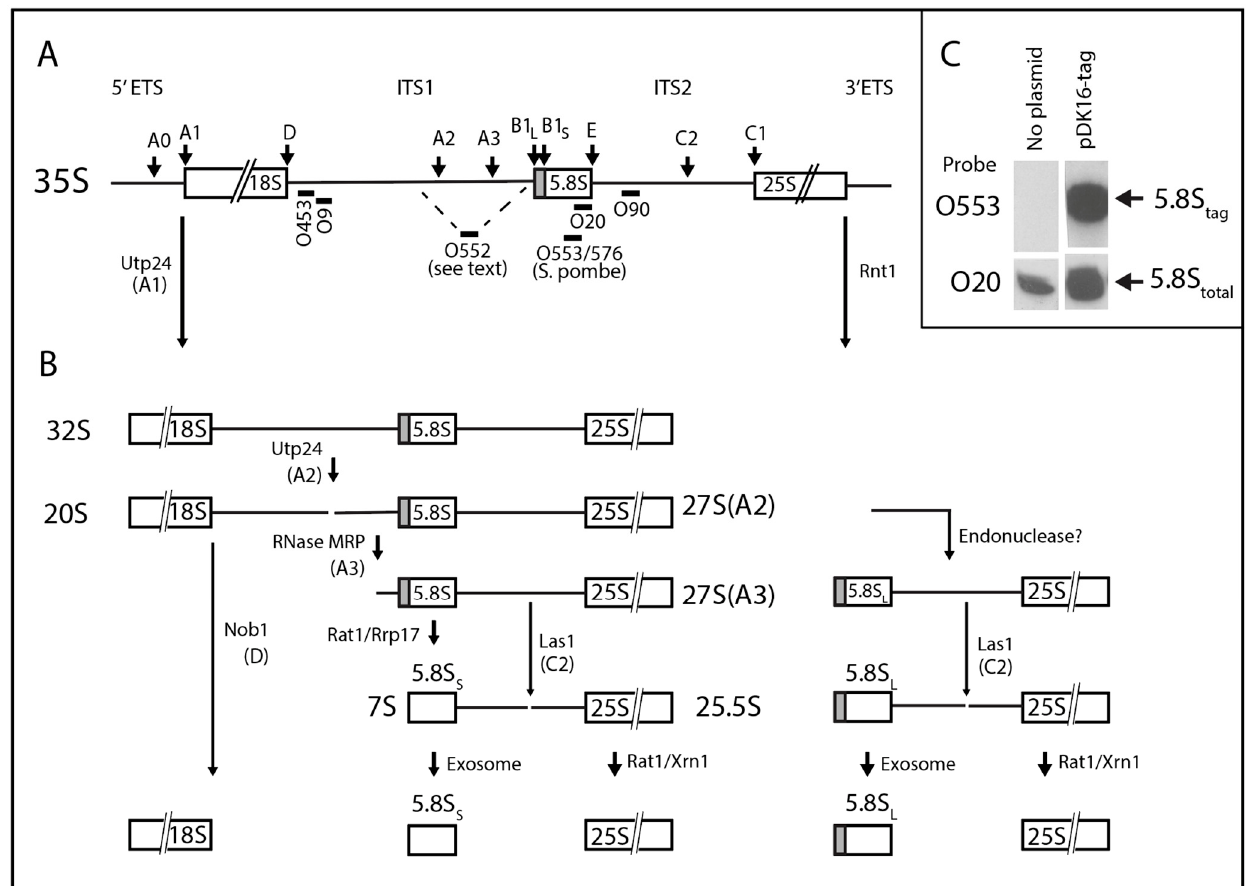
Figure 1. Canonical rRNA processing pathways. ( A ) Map of the yeast RNA polymerase I-transcribed rRNA transcription unit with processing sites (above map) and oligonucleotides used for probing northern blots (below map). See Table 1 for oligonucleotide sequences and positions of pre-rRNA to which they hybridize. ( B ) rRNA processing intermediates with names of relevant processing enzymes and their sites of action. Only relevant steps are shown. ( C ) Specificity of northern probe for tagged 5.8S rRNA. ∆ rpa12 without plasmid or carrying pDK16-tag wildtype was grown at 25° and shifted to 37° for 6 h. Total RNA was analyzed by northern analysis using the O553 probe (complementary to the S. pombe tag in 5.8S rRNA on pDK16-tag) or the O20 probe (complementary to the 25 nucleotides at the 3 ′ end of 5.8S rRNA).